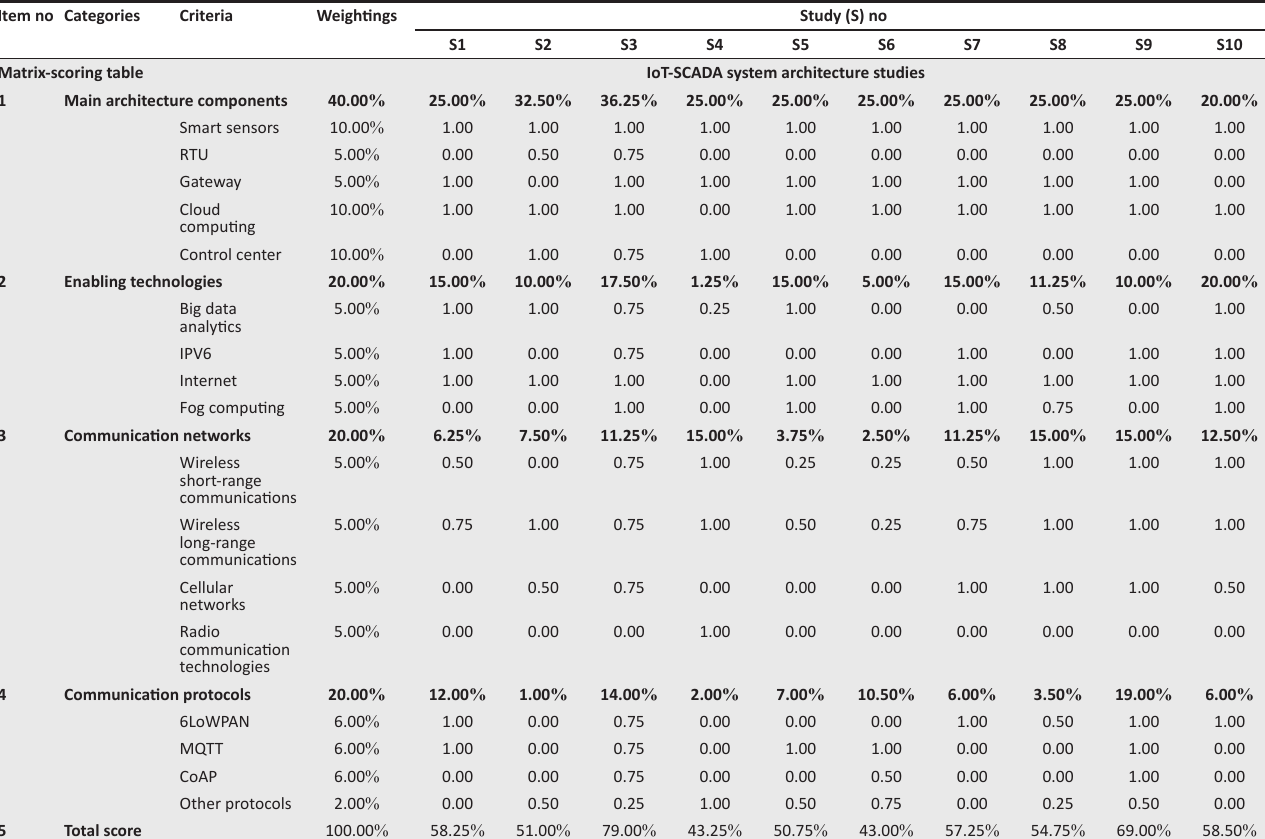
TABLE 4: Multi-Criteria Decision-Making matrix scoring results. Item no Categories Matrix-scoring table Main architecture